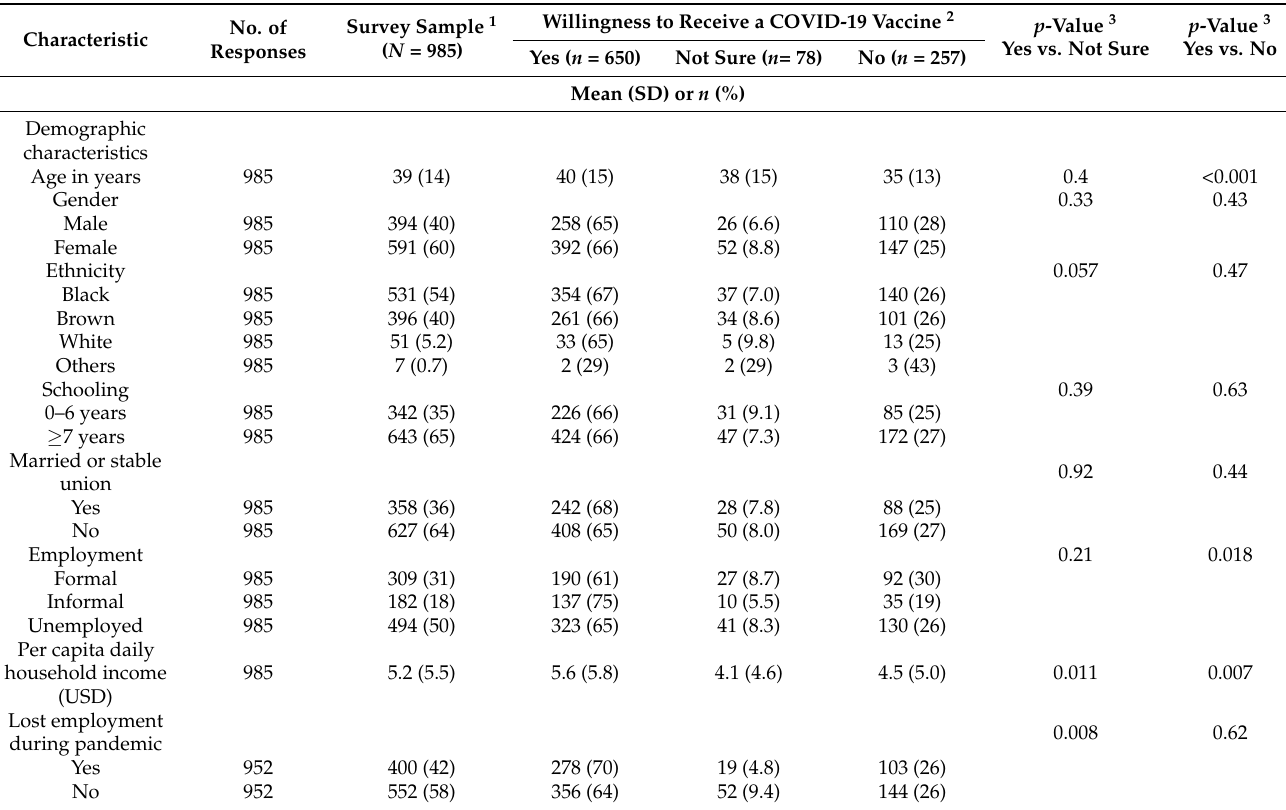
Table 1. Participants’ demographic characteristics and COVID-19 diagnoses and exposures among Pau da Lima residents and willingness to receive COVID-19 vaccination.